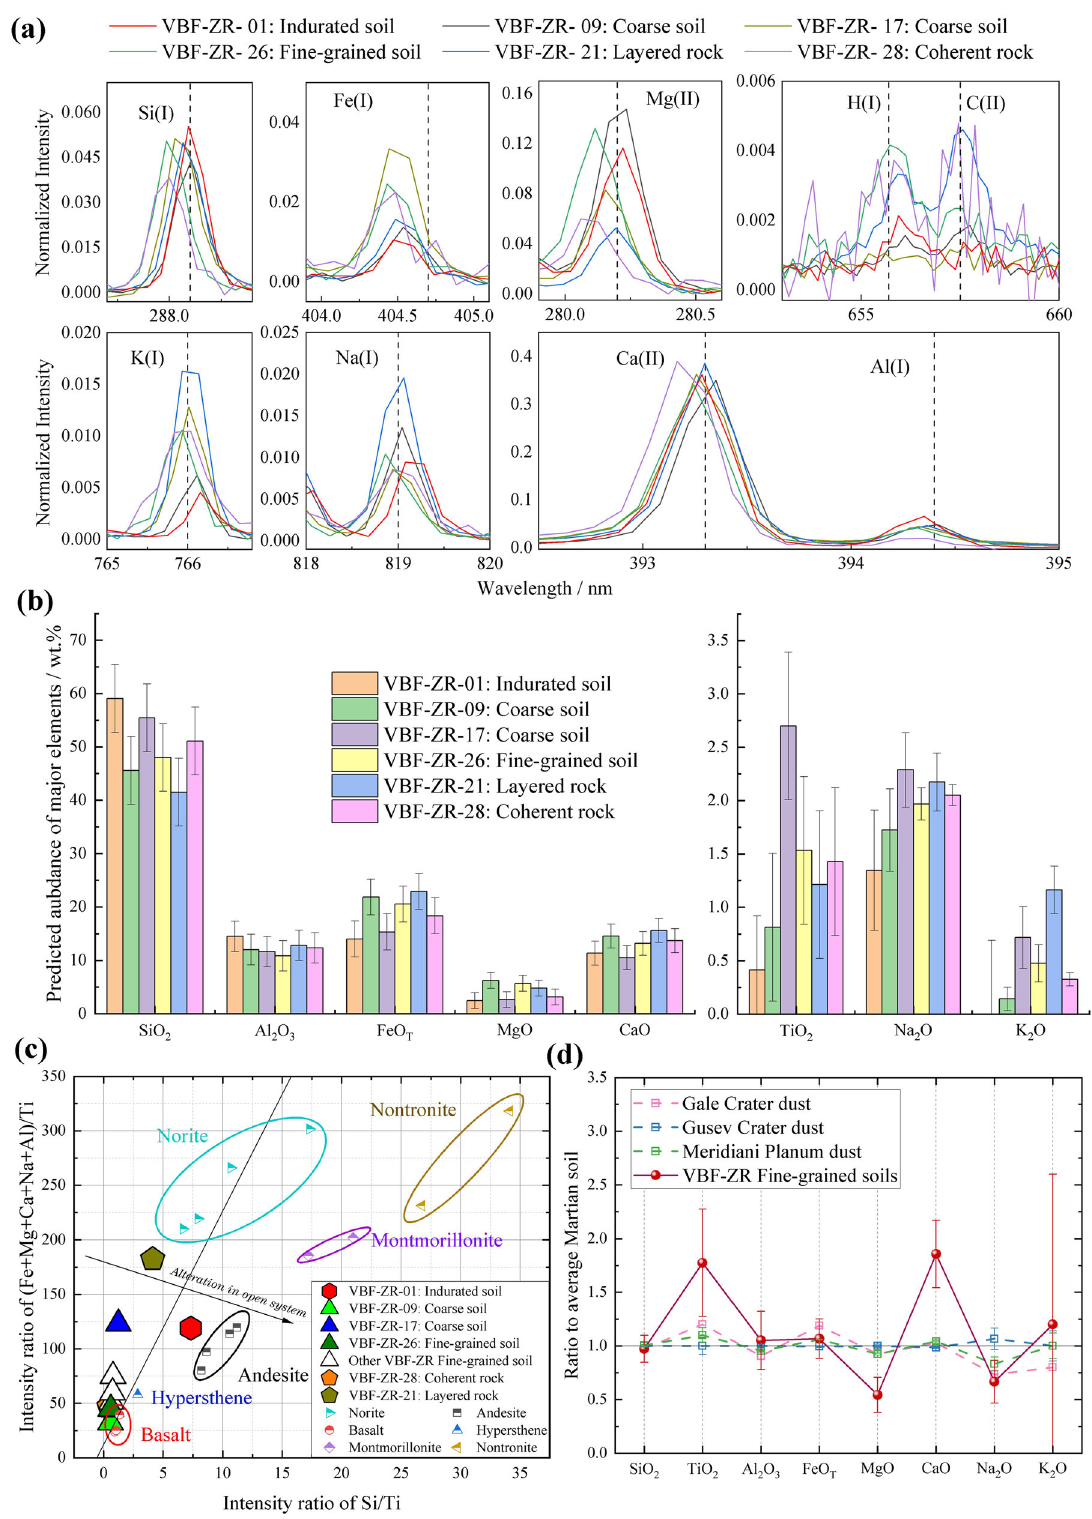
Fig. 3 LIBS spectra and chemical compositions of selected VBF-ZR targets. a Selected and normalized emission lines of Si, Fe, Mg, H, C, K, Na, Ca, and Al of six targets. b Major element concentrations in VBF-ZR targets, where the error bars are RMSEs of the multivariate model used in this study. c Cluster analysis using LIBS spectral line intensity ratios of the selected VBF-ZR targets and seven silicate cal-targets carried by MarSCoDe. The black line is a linear fi t result using scatters of basalt, hypersthene, and norite cal-targets ( R 2 = 0.89). d Relative concentrations of eight major elements at four landing sites normalized to the average Martian soil compositions (data in Supplementary Table 7). The error bars are the ratios between error values and average Martian soil